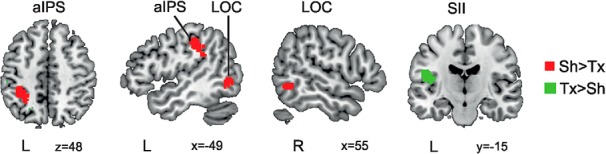
Property-selective haptic ROI creation from localizer task. In red, regions more active during the haptic shape than texture processing (left anterior intraparietal sulcus -aIPS- and bilateral lateral occipital complex -LOC-). In green, regions more active during the haptic texture than shape processing (left secondary somatosensory area -SII- , parietal operculum).